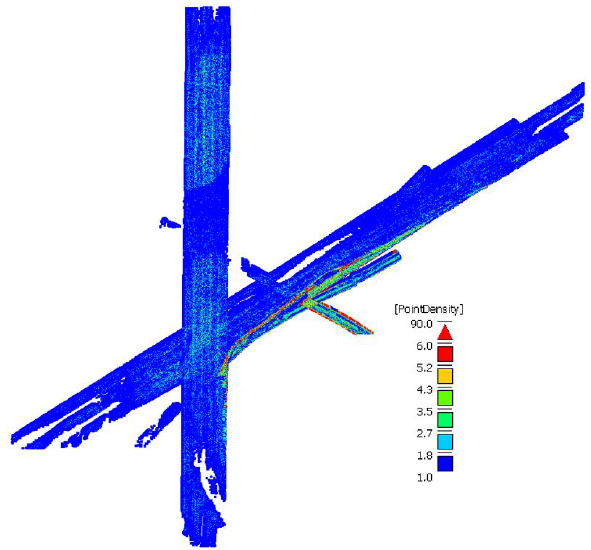
Figure 2: Pilot study - point density of Hawkeye